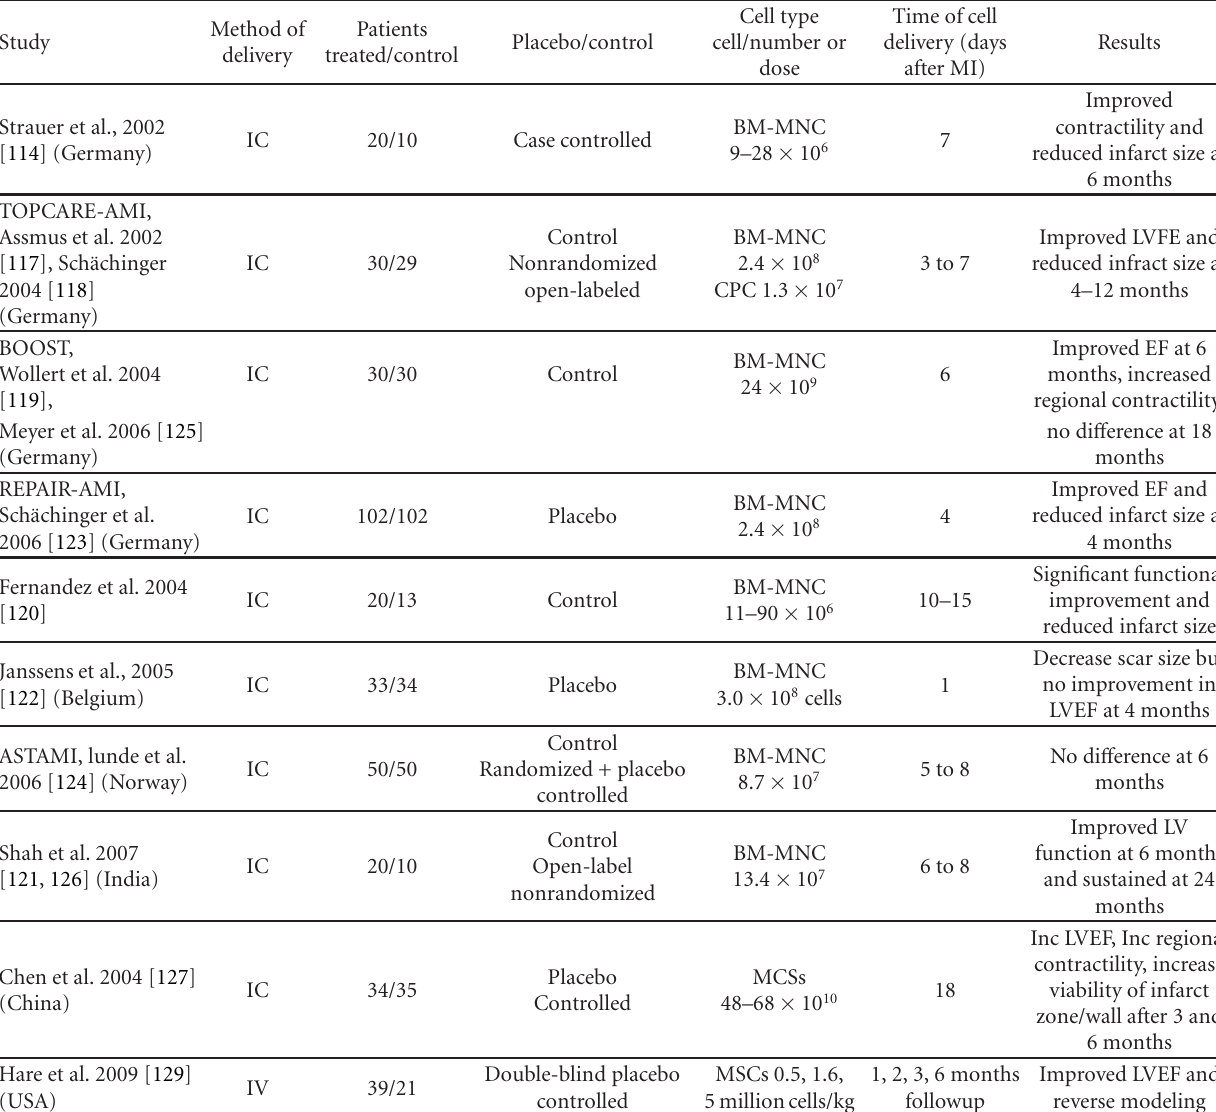
(a) Summary of major cell-based clinical